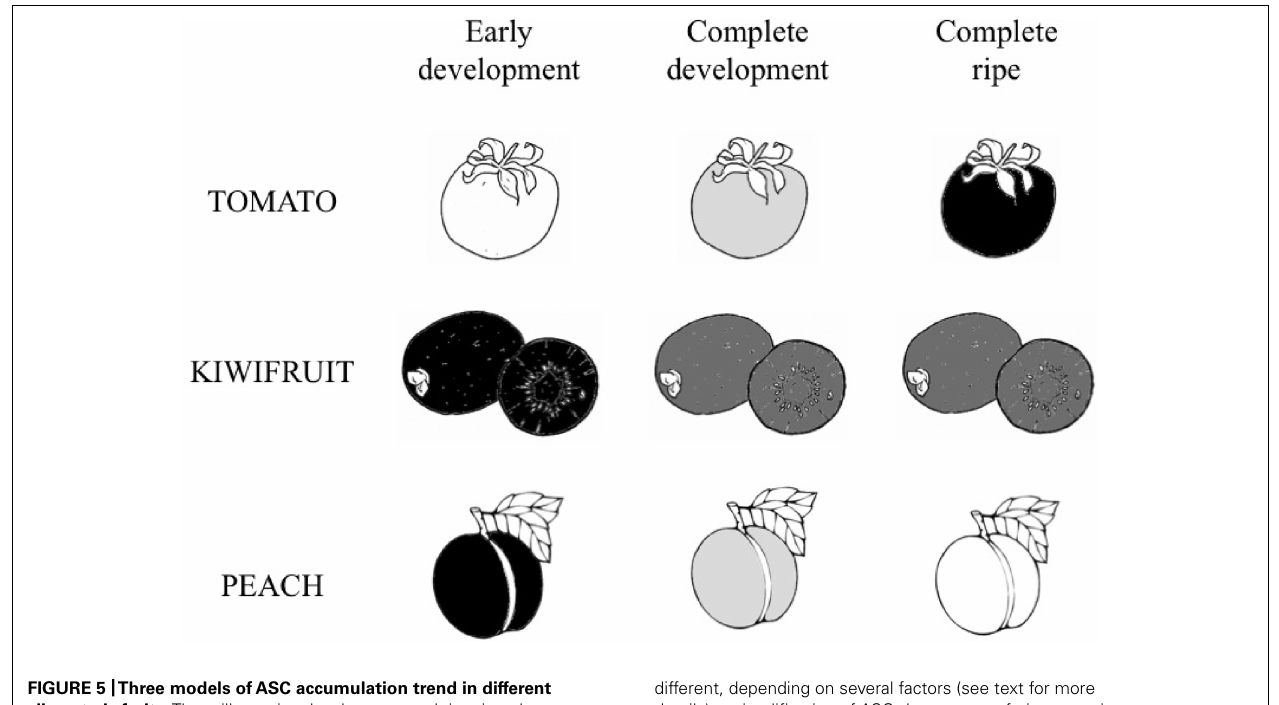
FIGURE 5 |Three models ofASC accumulation trend in different climacteric fruits. Three illustrative development and ripening phases of different fruits.White, gray and black colors correspond to the lowest, intermediate and the highest ASC content, respectively. Since the timing of the diverse stages, as well as the vitamin C levels, are quite